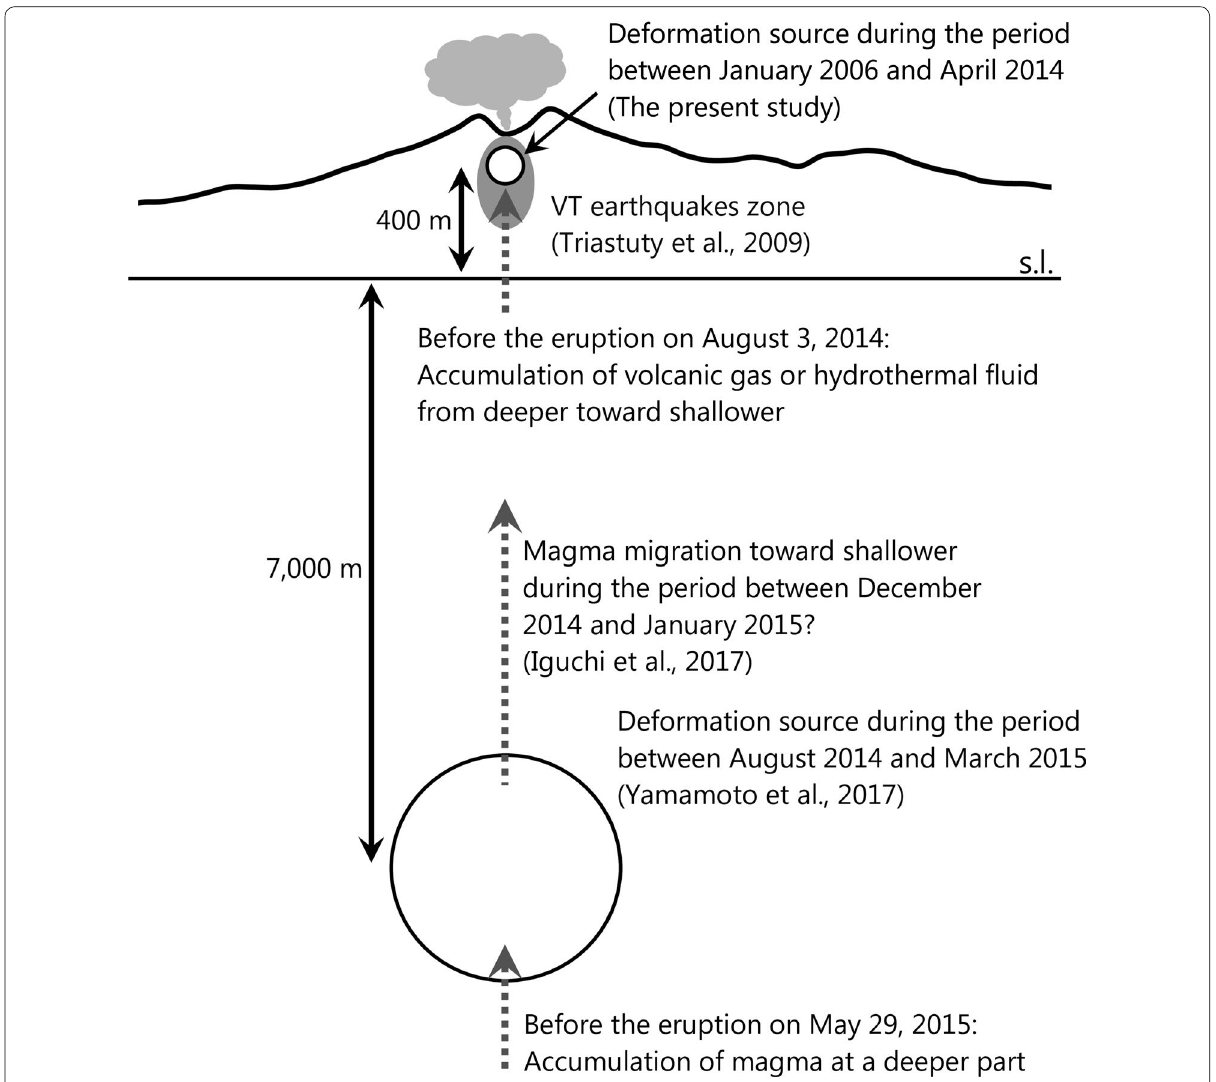
Fig. 12 A cross-sectional profile of the Kuchinoerabu-jima with indication of the deformation sources obtained in the present study during 2006–2014 and previous study during 2014–2015 (Yamamoto et al. 2017), and VT earthquakes zone (Triastuty et al.